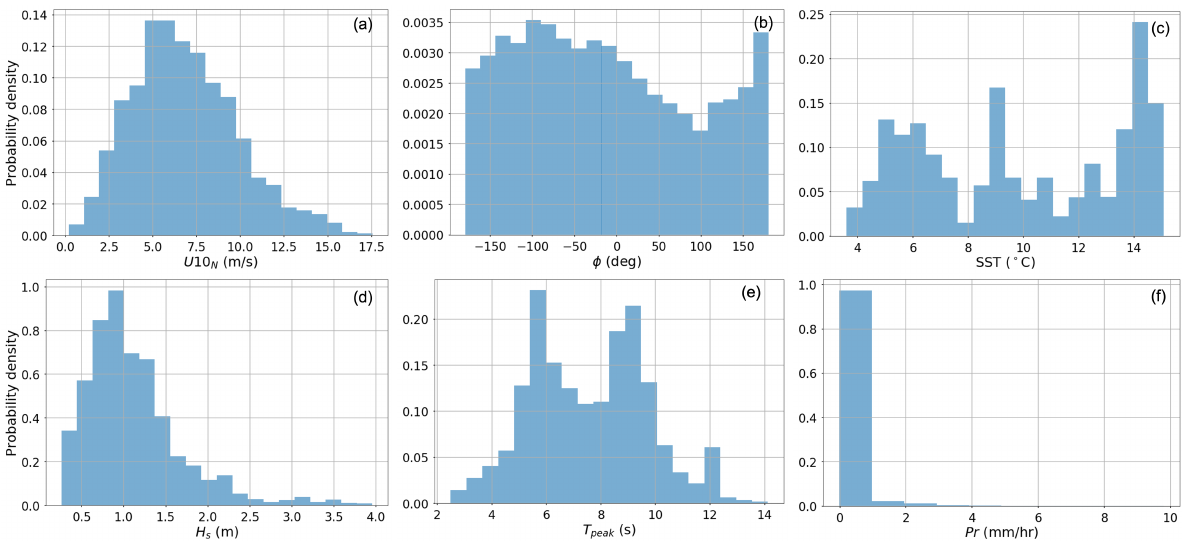
Figure 2. Probability density of ( a ) equivalent neutral wind speed U 10 N , ( b ) relative wind direction Φ , ( c ) sea surface temperature SST, ( d ) significant wave height H ( f ) precipitation rate P r